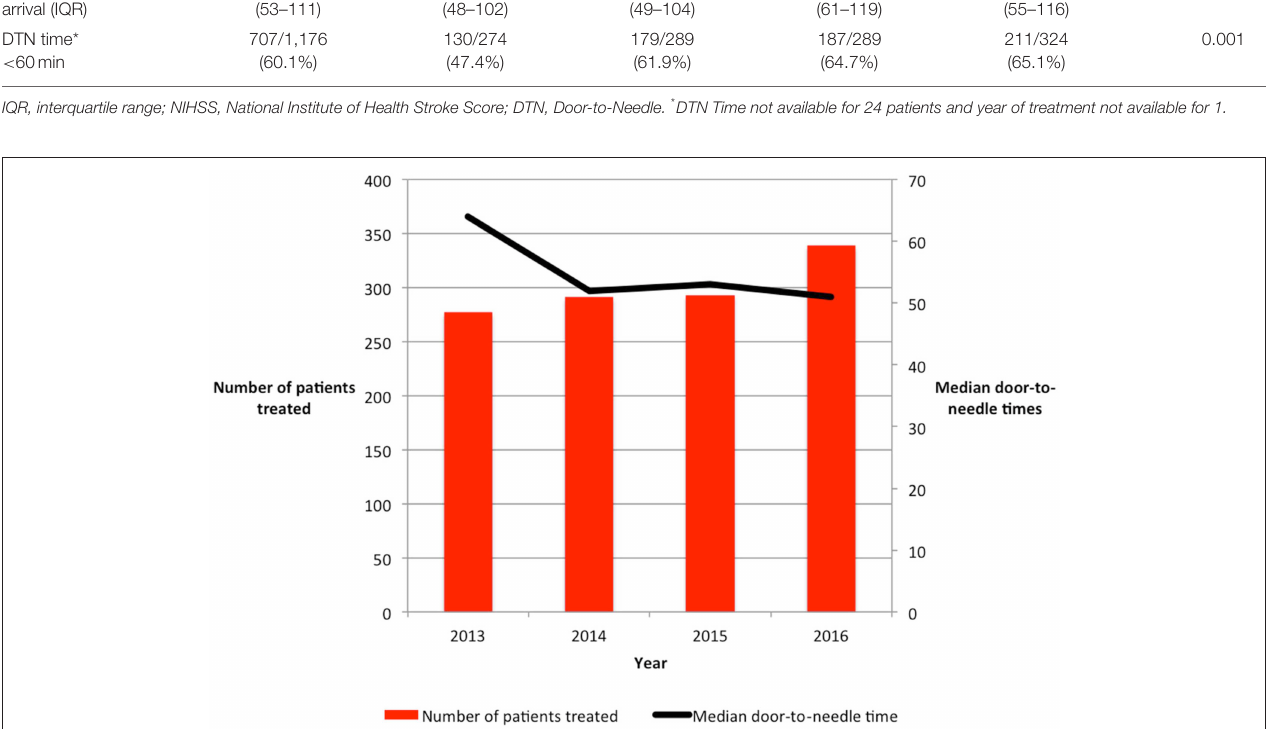
patients (51%) were male. Median NIHSS was 10 (IQR 6-16) and varied significantly between hospitals from 8 to 12 ( P =